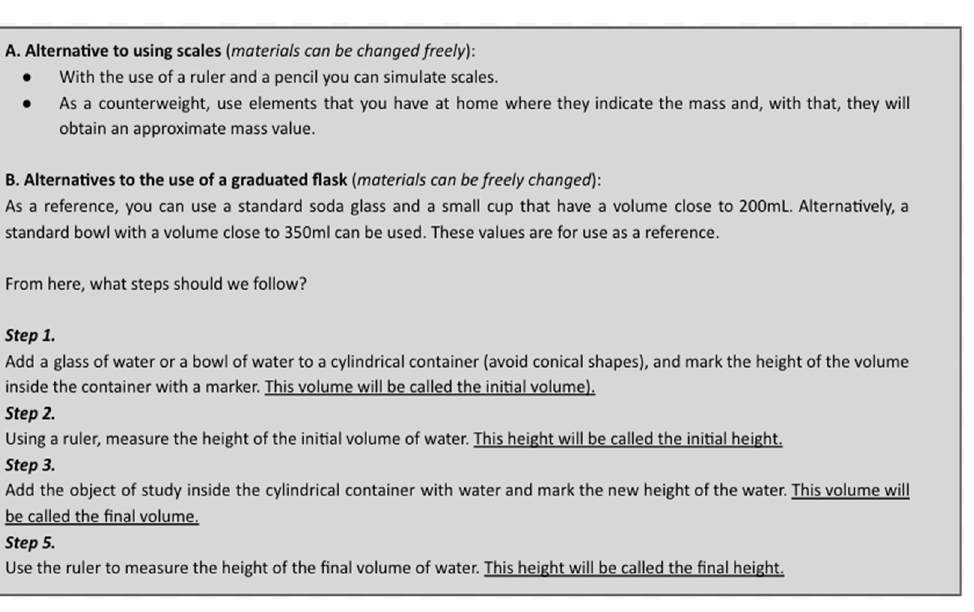
Figure 2. Solutions or alternatives of the first laboratory work based on the “Study of the density of irregular bodies at